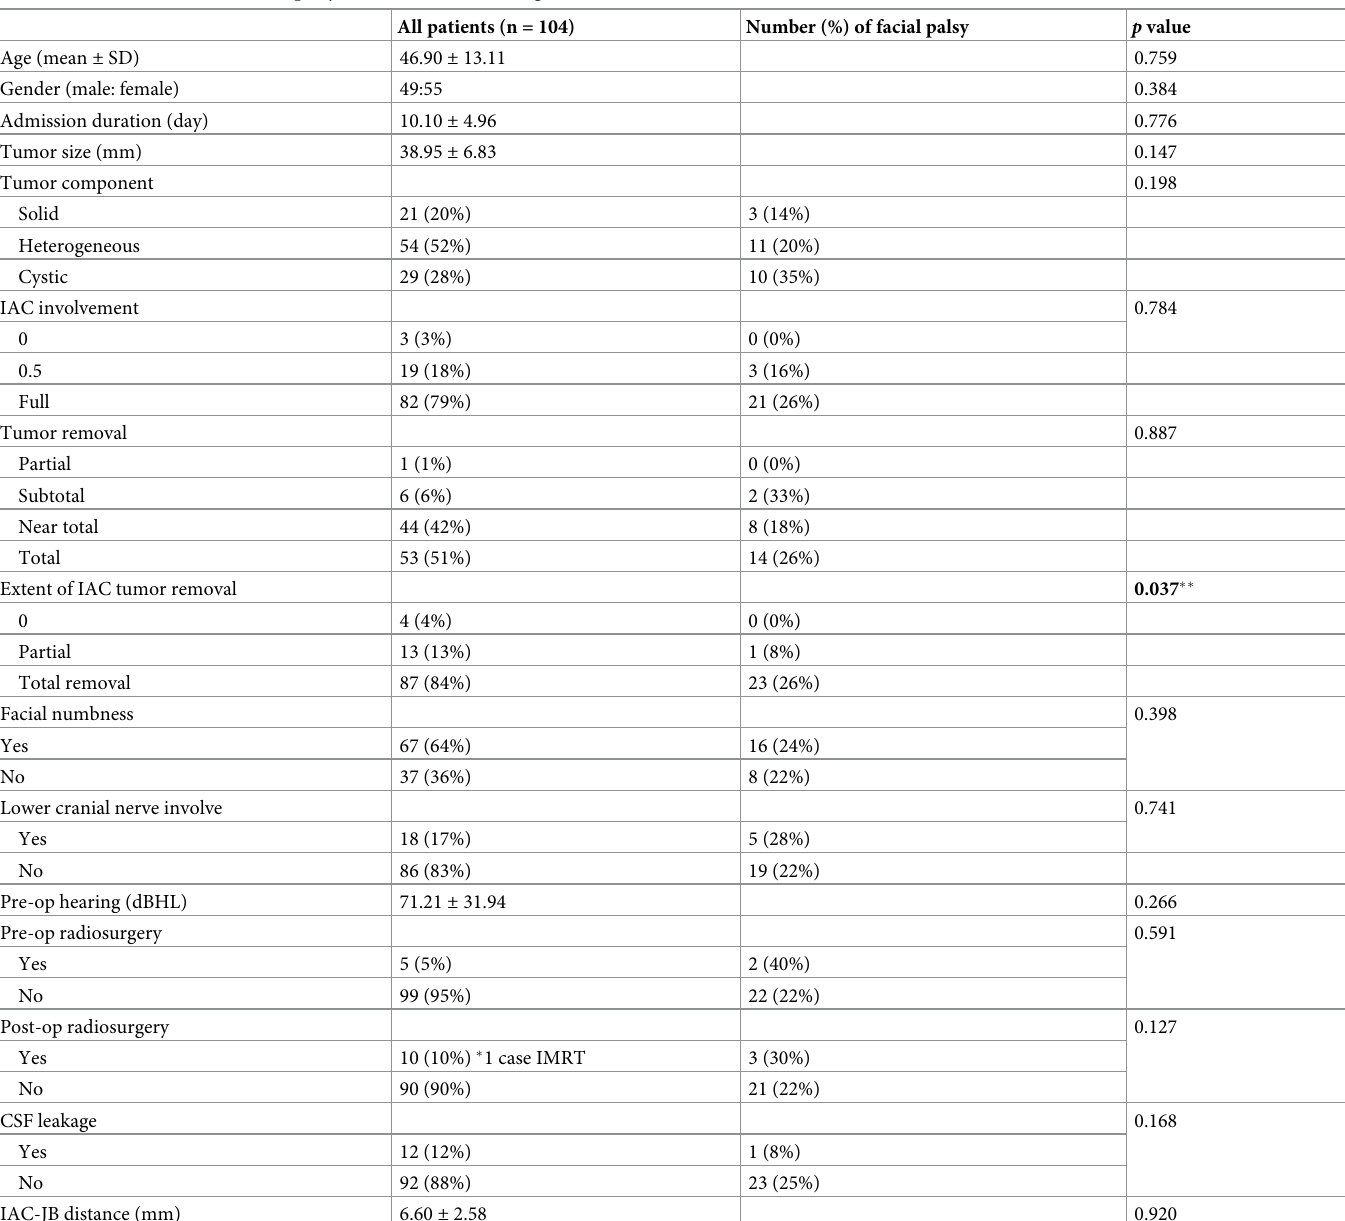
Table 2. Predictive factors of facial palsy (multivariable linear